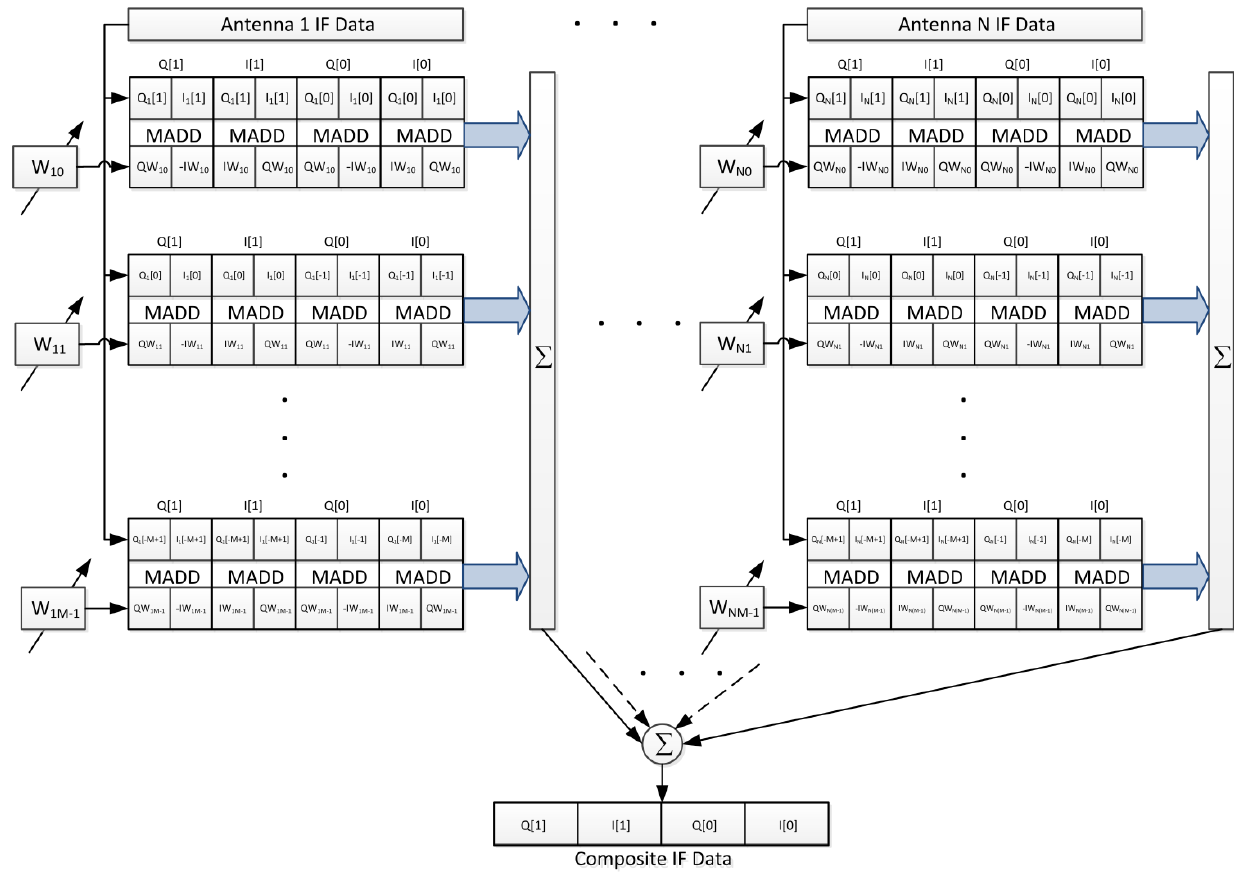
Figure 10. Architecture of weight and sum including data formatting and used SIMD